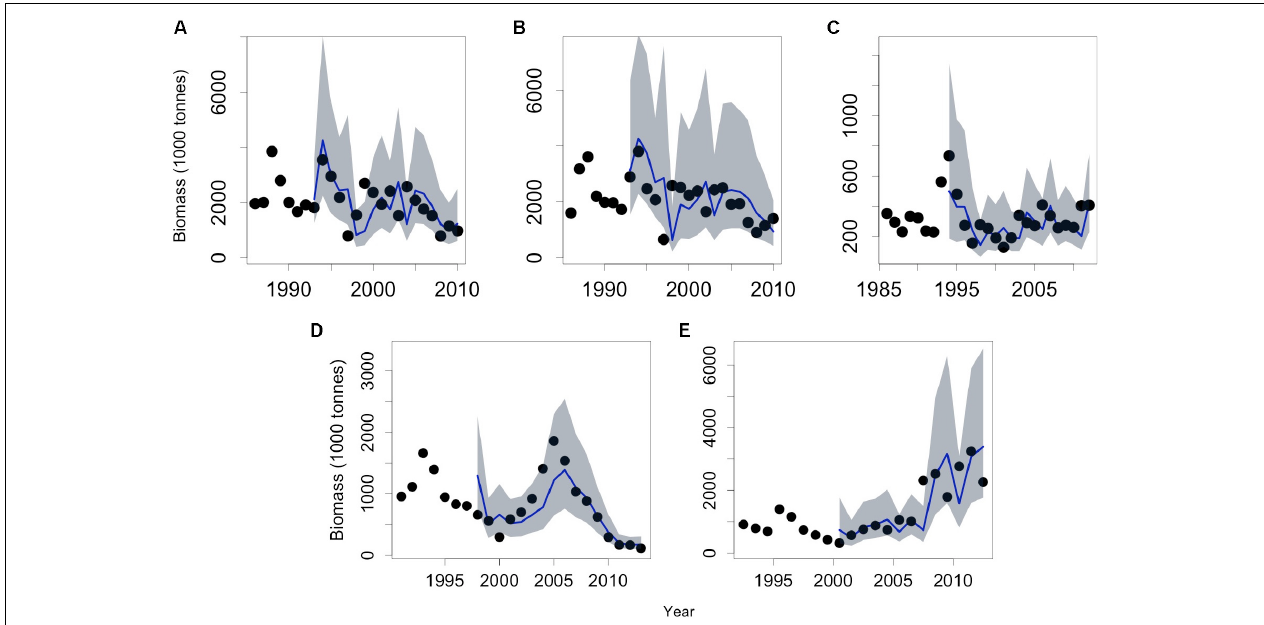
FIGURE 4 | Simulations of the anchovy and common sardine biomasses with the selected models in Table 1 . (A) APCH-S1 population ( Table 1 , S1.m12). (B) APCH-S2 population ( Table 1 , S2.m10). (C) ACN population ( Table 2 , m13). (D) Anchovy population of central southern Chile ( Table 2 , m11), and (E) common sardine population of central-southern Chile ( Table 3 , m12) (points correspond to the observations, the blue line to the prediction, and gray area to the confidence interval of the